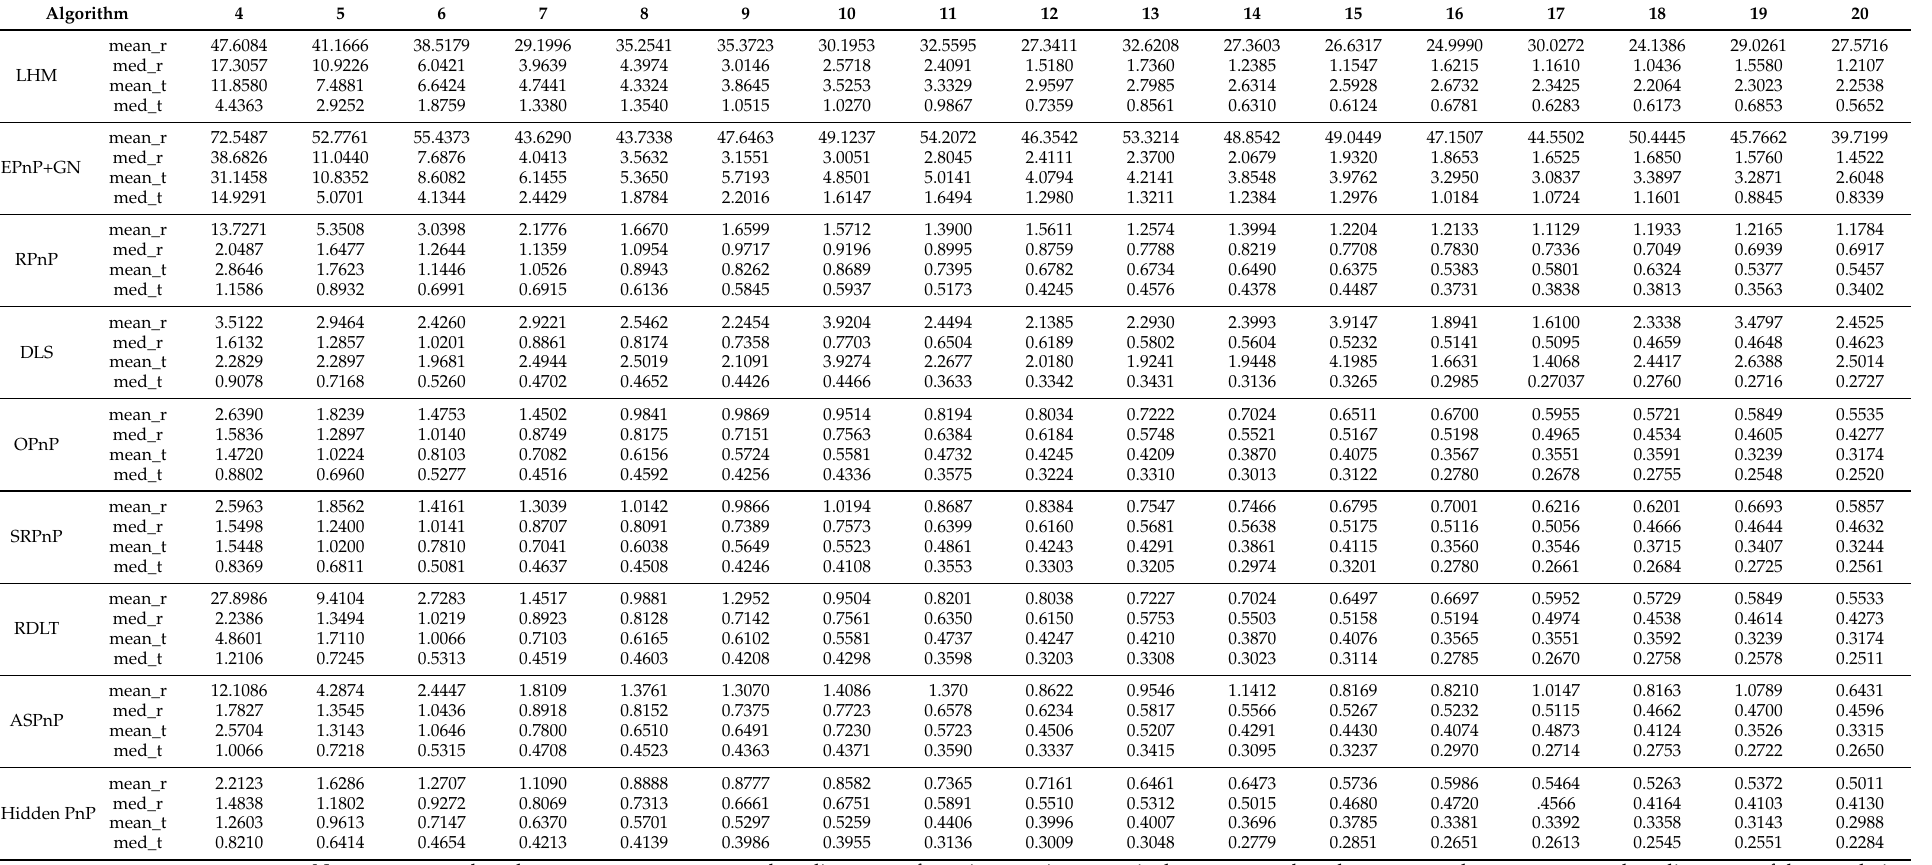
Table A2. Error comparison in the Planar